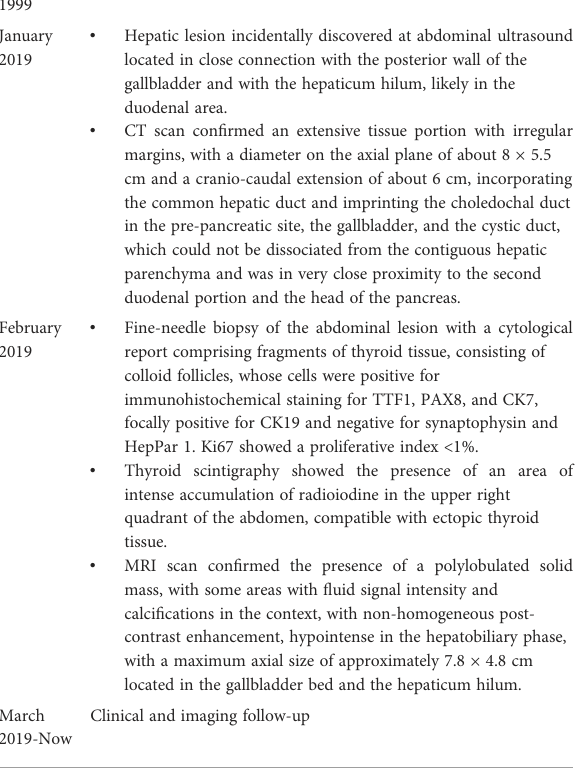
TABLE 1 Clinical and biochemical parameters of the patient from the fi rst observation and during the follow-up. Clinical parameters